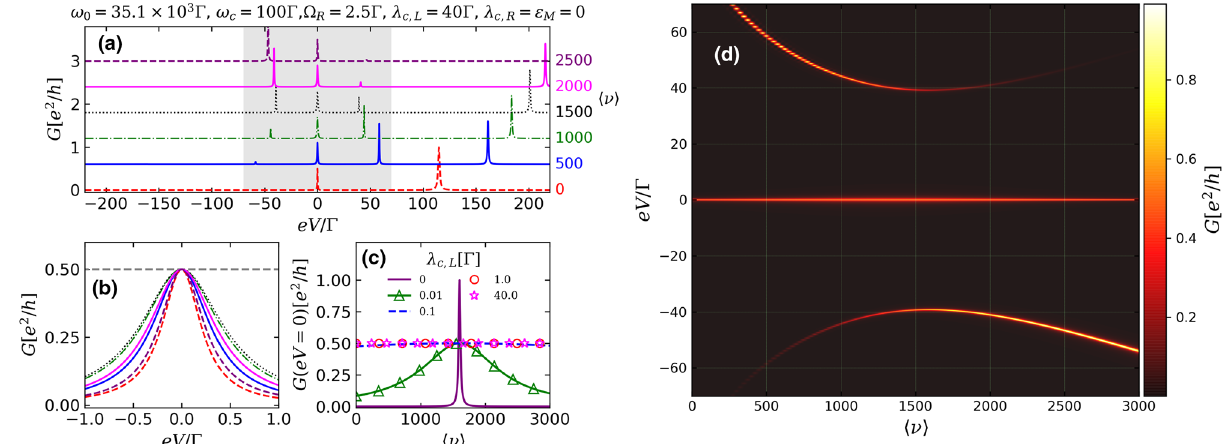
Figure 2. ( a ) Conductance through the QD [Eq. (6)] as a function of bias-voltage eV describing the case of (cid:31) highly nonlocal MZMs ( ε M c , R = 0 , η = 0 ) for increasing number of the excitations in the system (cid:31) ν (cid:30) , which = can be tuned by external pump (the curves are offset along the y axis for the better viewing). One clearly sees 0 . ( c ) the appearance of additional peaks due to the Rabi splitting. ( b ) Zoom of the conductance around eV = 0 for increasing ν Conductance through the QD at zero-bias eV . ( d ) Colormap showing the conductance = (cid:31) (cid:30) ν behavior as a function of both the eV and , for a range of eV corresponding to gray region of ( a (cid:31) (cid:30) 500 (solid blue line, Fig 2a), optically-induced transitions between ν For a finite photon occupation � � = valence and conduction levels of the QD come into play, splitting the single peak associated with the QD conduc- 50 Ŵ and eV 150 Ŵ . The higher is the value of ν tion level into two polariton peaks located at eV , the bigger ≈ ≈ (cid:31) (cid:30) is the distance between the polariton peaks (Fig. 2a, dash-dotted green and dotted black lines). This behavior ν 49 (Fig. 1b). Note, however, resembles the Rabi splitting for an individual dot inside a cavity, for which 2 � R √ � � ν that for sufficiently high values of additional polariton peaks stemming from indirect MZM to photon cou- (cid:31) (cid:30) pling of lower amplitude appear (see black and magenta curves). The amplitude of the peak at zero-bias remains unchanged with increase of the number of the photons (Fig. 2b). This robustness is characteristic for the situation of highly-nonlocal MZMs 22,23,25,32 . In the same time, the width of the ZBP is monotonously increasing with increase of the number of the cavity photons, which means that the latter affect the effective lifetime of the electronic states of the dot and MZMs. ν In Fig. 2c, the conductance behavior at zero-bias as a function of is shown for several values of (cid:31) c , L . A (cid:31) (cid:30) well-defined plateau of 0.5 e 2 / h , independent on the mean photon occupation, characterizes the robustness of the ZBP for the cases of strong QD-nanowire coupling (cid:31) c , L (cid:31) Ŵ (magenta stars and red circles). For smaller values of (cid:31) c , L , the plateau is destroyed, as can be seen in the green line with triangles of Fig. 2c, corresponding to 2 Ŵ . When the QD is totally decoupled from the Majorana nanowire (solid purple line, (cid:31) (cid:31) c , L = 10 − c , L = 0 ), the 0 exhibits a single resonance at 1600 , which corresponds to the crossing between ν conductance at eV = � � = the photon-induced lower polariton peak and Fermi energy. 0 have its amplitude reduced with the co-emergence of a conductance peak symmetrically localized above eV = 0 and a ZBP with unchanged 0.5 e 2 / h height pinned at zero-bias. Direct comparison between profile below eV =